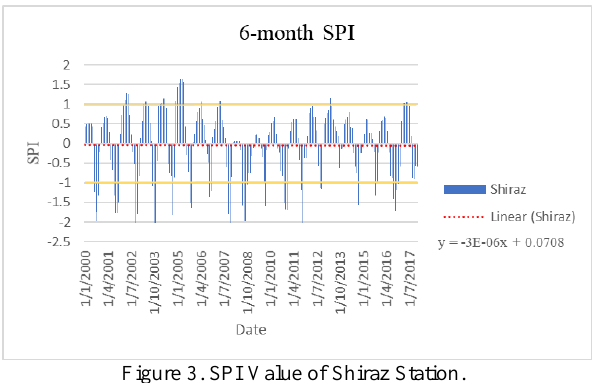
Figure 3. SPI Value of Shiraz Station.